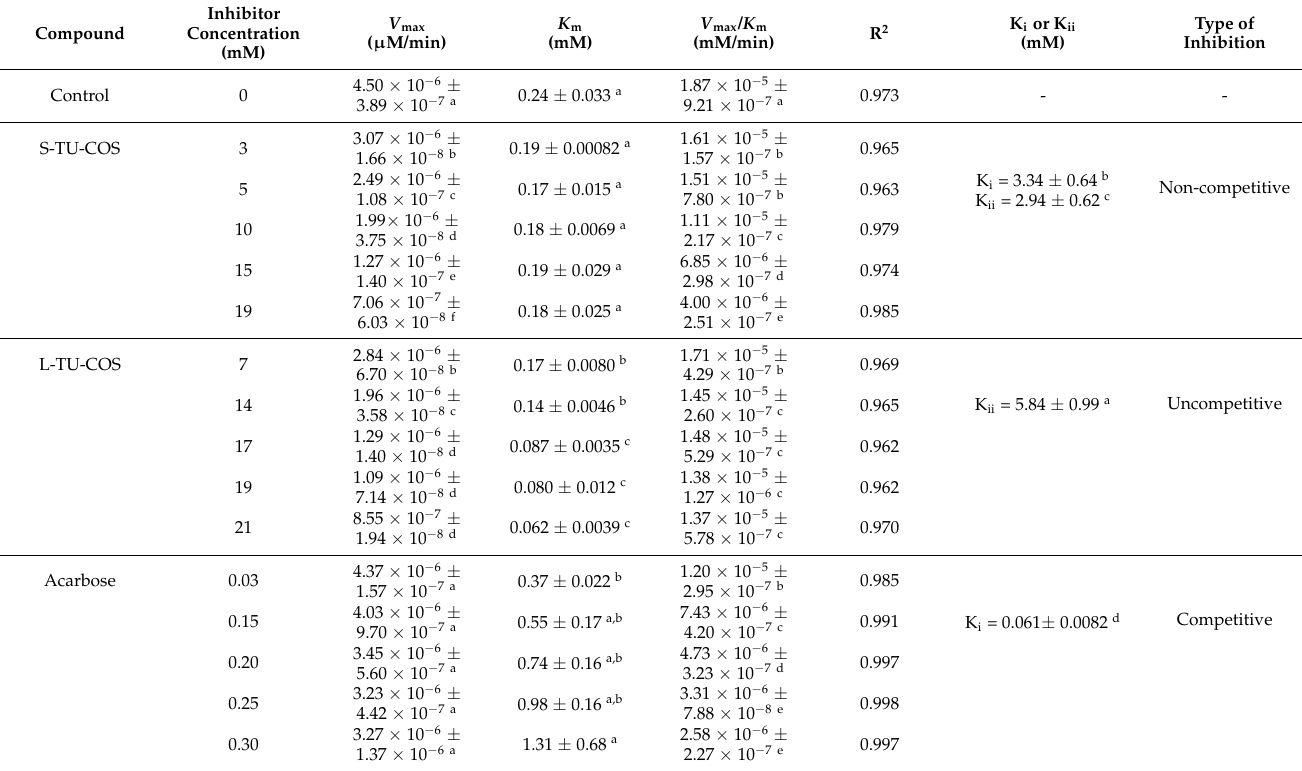
Table 3. Kinetic parameters of S-TU-COS, L-TU-COS, and acarbose (positive control) on α -glucosidase inhibition from the Michaelis–Menten